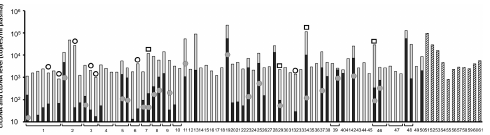
Fig 2. Wild-type and mutant DNA levels measuredby dPCR in 87 plasma samples from 61 metastatic NSCLC patients. Greyed bar: circulatingcell-free DNA (cfDNA) concentration in NSCLC patients with confirmedtargetableEGFR mutations in tumor tissue. Filled bar: sensitizing(Del19,p.L858R and p.L861Q) mutations concentration. Dashedbar: wild-typeDNA concentration in NSCLC patients with wild-typeEGFR in tumor tissue. Grey dots: p.T790M mutation concentration. Empty circles and squaresindicatessensitizing and resistancemutationspositives by dPCR but not detected by NGS respectively.